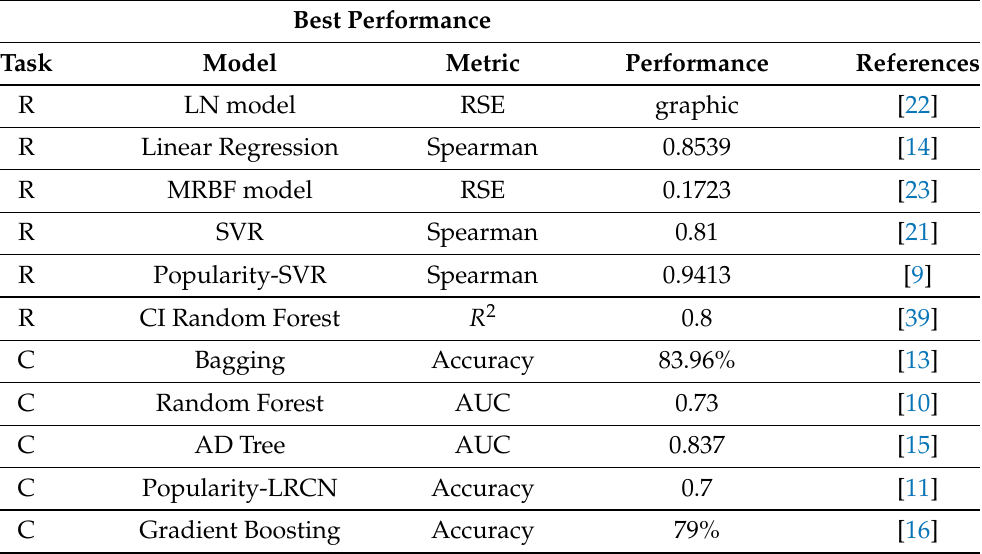
Table 2. Performance of